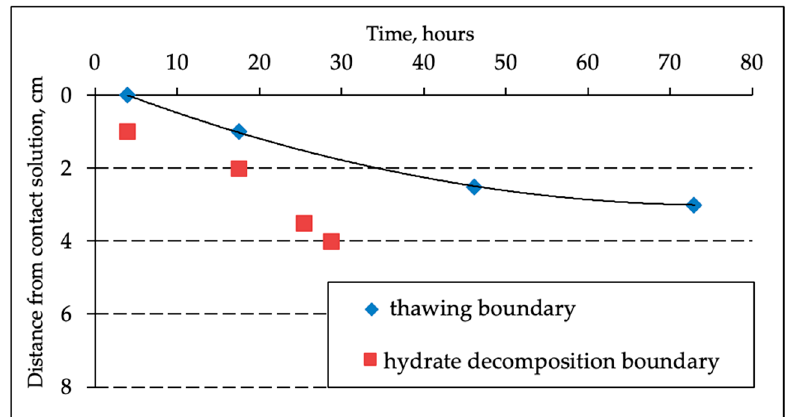
Figure 4. Experimental assessment of the gas hydrate decomposition front in porous media and the thawing front in frozen hydrate-containing sandy samples (sand-1, W = 14%) when interacting with 0.2 N NaCl salt solution at the temperature − 4 °C.